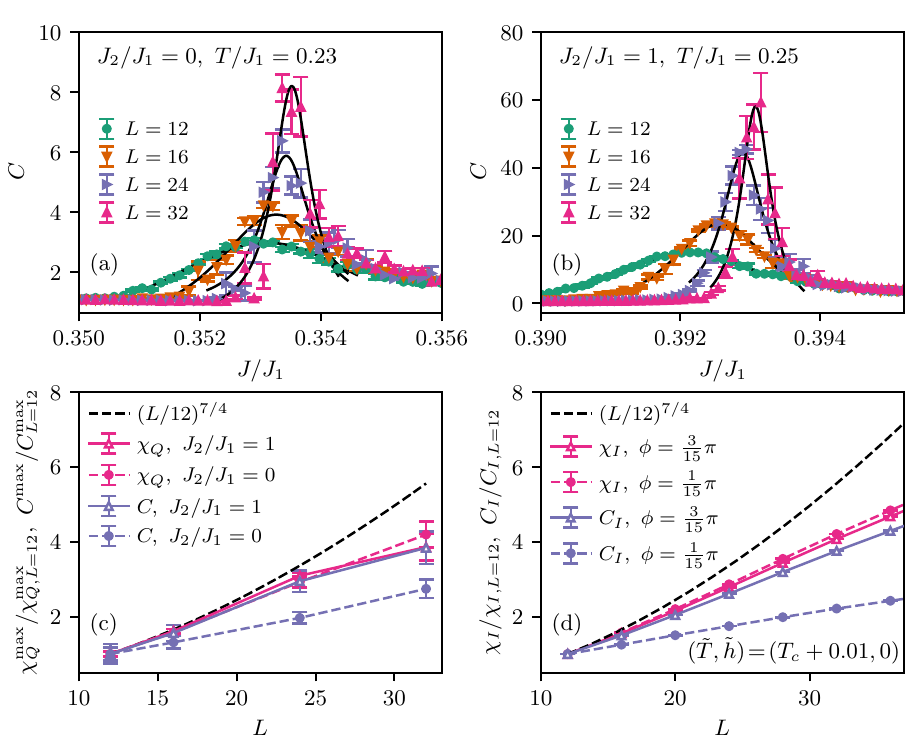
Figure 8: Finite-size scaling of the specific heat, C ( J , T ) , close to the critical point for (a) a non-degenerate FFTL and (b) the degenerate FFTL. (c) Scaling of the specific- heat maxima, C max , shown together with the quartet susceptibility maxima, χ max normalized for comparison to their L = 12 values. The dashed black line shows a power law with the critical exponent γ/ν = 7 / 4. The temperatures are those of panels (a) and (b). (d) Scaling of the specific heat, C the rotated Ising model at different mixing angles, φ , normalized to their values with L = 12. The data are taken with a small offset from the critical point to mimic the situation in panel